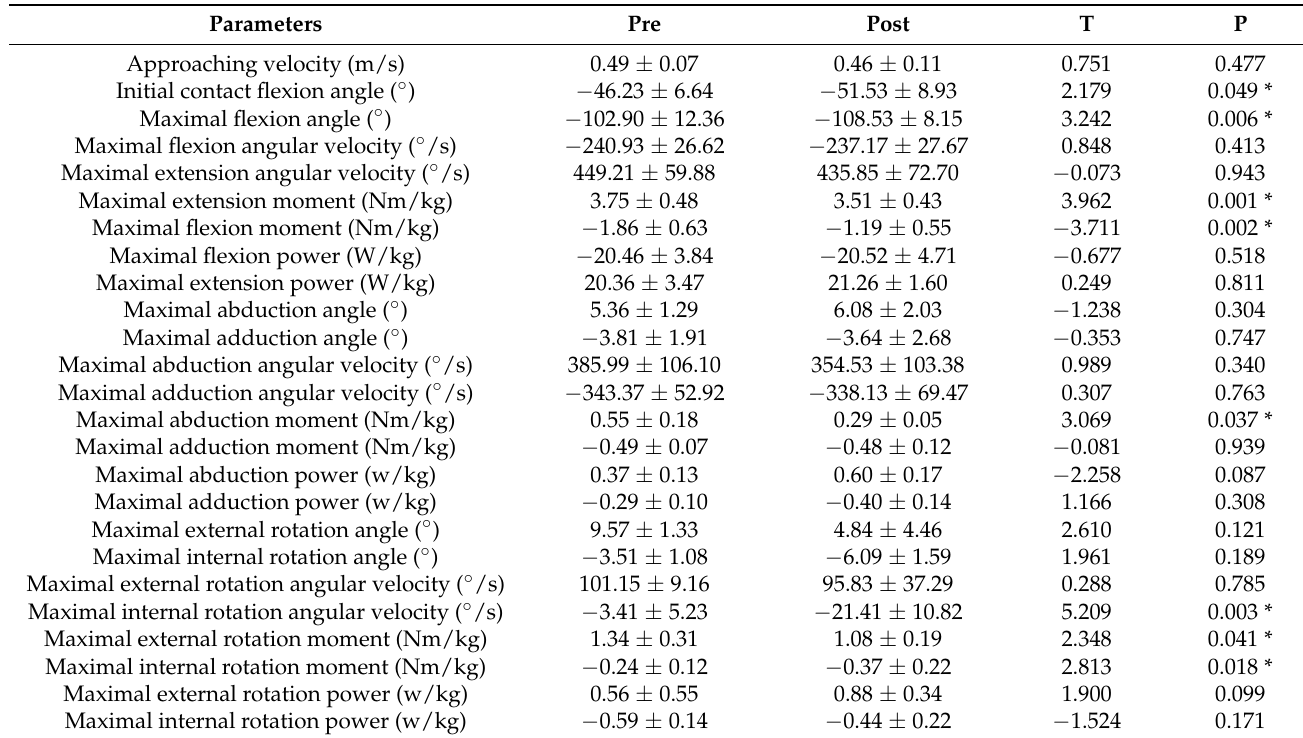
Table 2. The outcomes of knee kinematics and kinetics in three-movement planes.